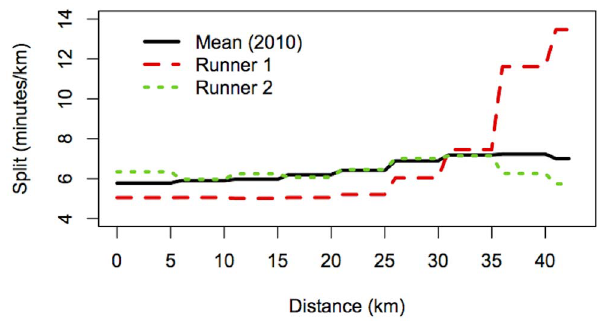
Figure 3. 2010 Split profile comparisons. Comparison of split profiles of two runners from the 2010 Boston Marathon along with the 2010 mean from Figure 2.